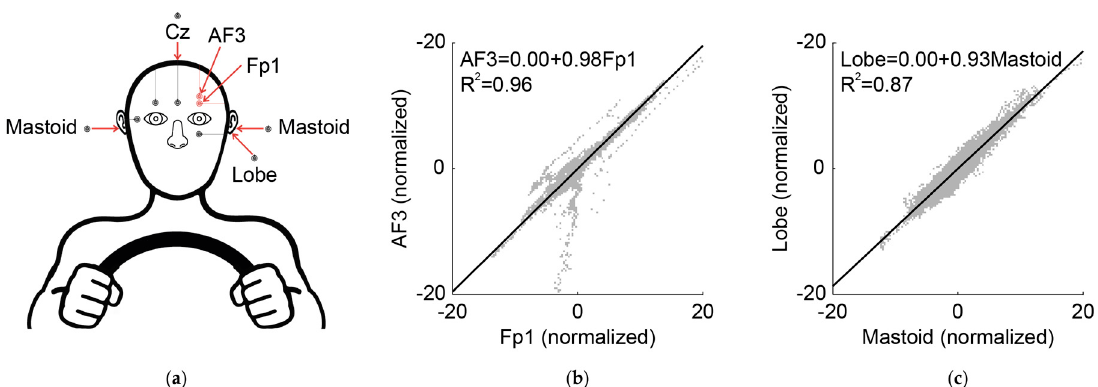
Figure 3. Differences between recording sites (Fp1 and AF3) and reference sites (mastoid and lobe) when recorded with the SOMNOwatch. ( a ) EEG recording configuration. Red arrows indicate the four electrodes’ placements of the SOMNOwatch used to compare the data. ( b ) Linear regression model for Fp1 and AF3 when recorded with the SOMNOwatch for five participants. The cloud of points shows the data for each subject first centered (by subtracting the average) and divided by its standard deviation, while the solid line represents the result of a linear regression of the form AF3 = b + g × Fp1. The numerical results for the regression and the correspondent determination coefficient are shown in the graph inset. ( c ) Linear regression model for Mastoid and Lobe references when recorded with the SOMNOwatch for five participants. In this case, the solid line represents the result of a linear regression of the form Lobe = b + g × Mastoid.